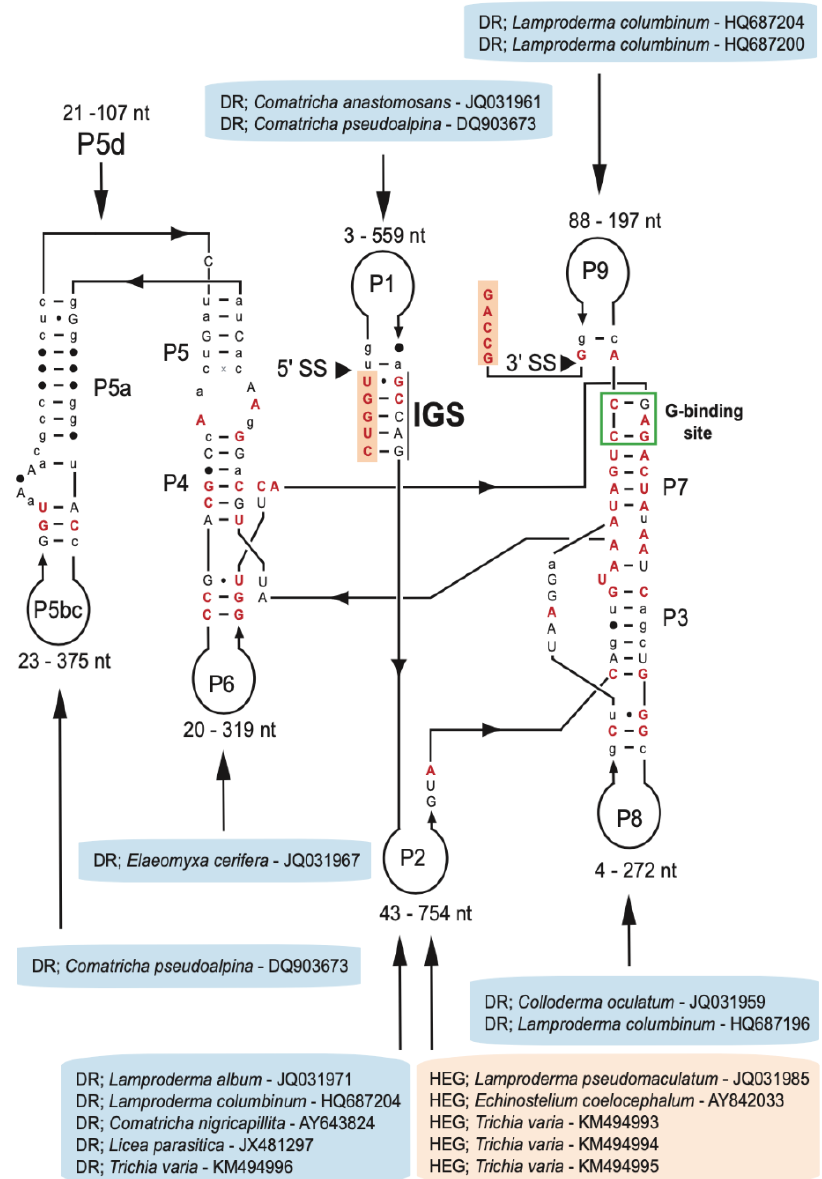
Figure 2. Consensus secondary structure diagram of S516 group I intron RNA in myxomycetes. The consensus structure is based on 143 nucleotide positions in the catalytic core common among introns from 75 taxa (see Table S1). Extensive sequence size variations are noted in peripheral regions. While all homing endonuclease genes (HEGs) are found as P2 extensions, direct repeat (DR) extensions are located in most peripheral regions. The guanosine (G) binding site in P7 is indicated. P1–P9, paired RNA segments; 5′ SS and 3′ SS, exon-intron splice sites. Invariant nucleotide positions among the 75 introns are shown as red uppercase letters. Black uppercase letter, ≥90% conservation; lowercase letters, ≥50% conservation; filled circles, <50% conservation.